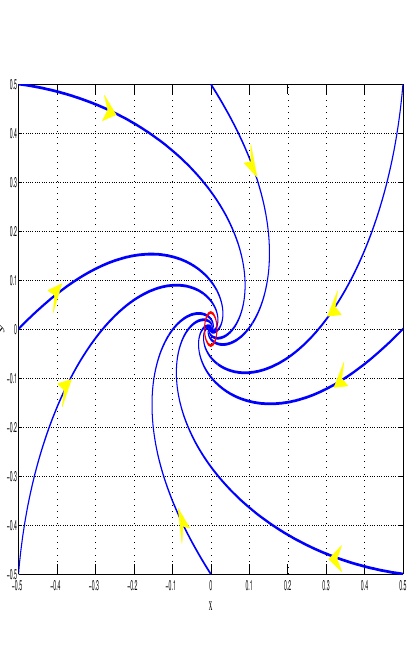
Figure 14. The numerical solutions generated by the NSFD scheme with h = 0 . 01 and t ∈ [0 , 1000] in Example